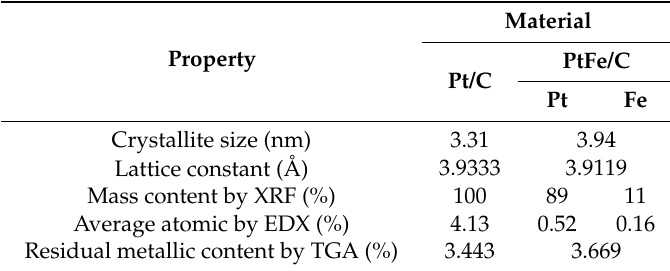
Table 1. Summary of the physicochemical results found for Pt/C and PtFe/C.